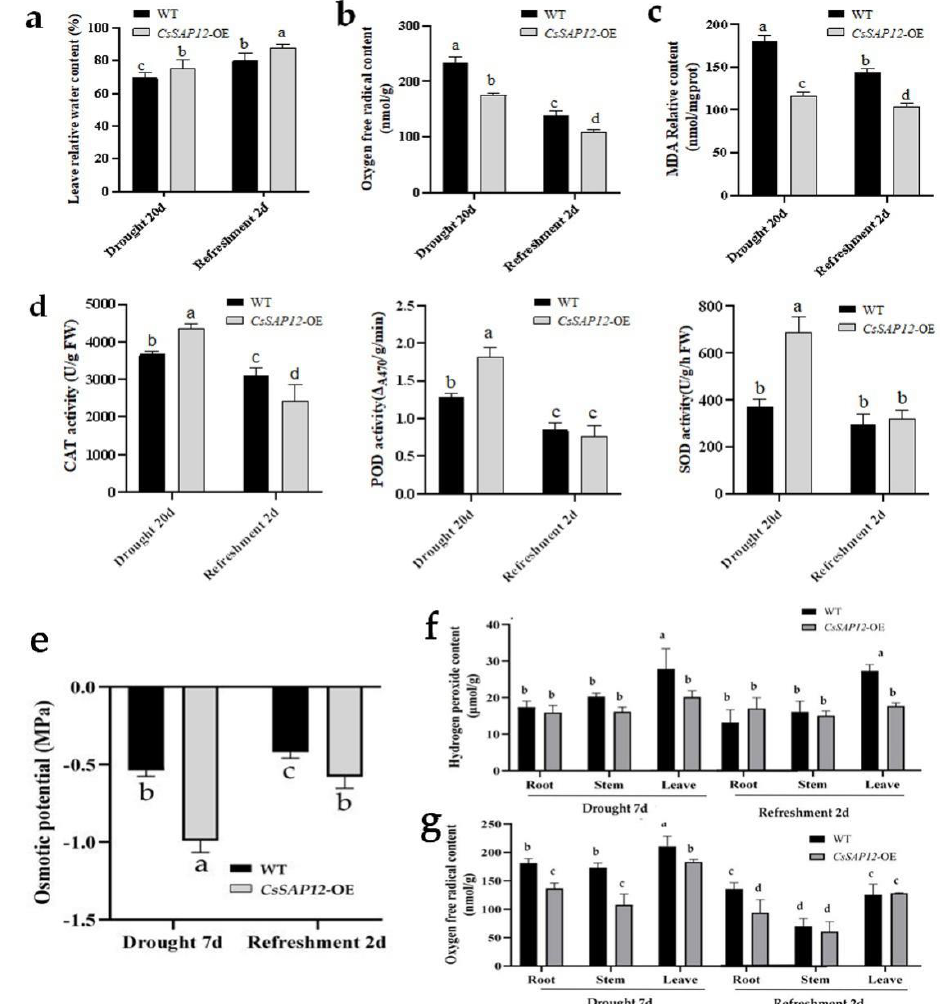
Figure 7. Stress physiological indices and antioxidant enzyme activities of wild types (WT) and CsSAP12 − overexpressed transgenic lines under drought stress. ( a ) Relative water content of leaves. ( b ) Oxygen free radical content. ( c ) MDA relative content. ( d ) Activities of antioxidant enzyme (CAT, POD, SOD) in WT and transgenic lines under drought stress and refreshment assay. ( e ) Osmotic potential. ( f ) Hydrogen peroxide and oxygen free radical content ( g ) of different tissues in WT and transgenic lines. The values are expressed as the mean ± standard deviation, and different letters of the alphabet a −d suggest significant differences calculated by Duncan’s multiple range test ( p < 0.05), error bars represent standard errors.